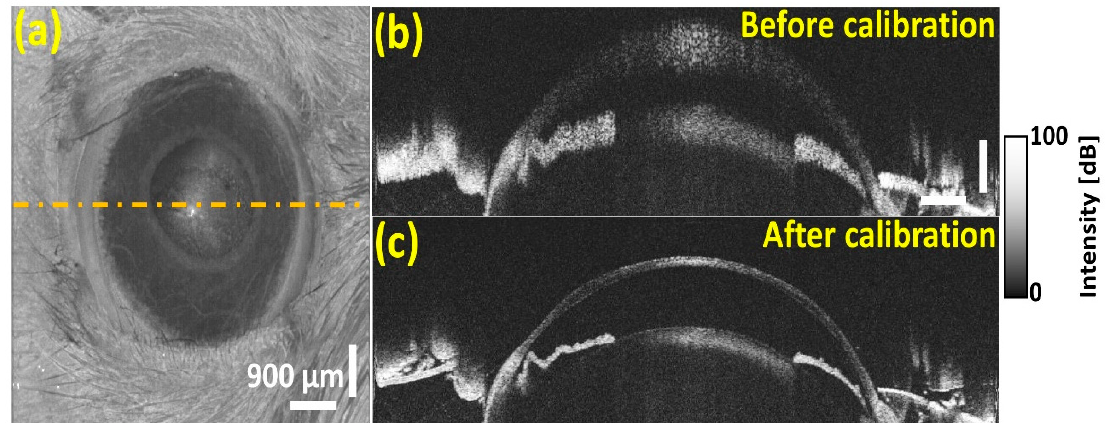
Figure 11. The OCT image verification of in vivo rat anterior vitreous opacification along with B-scans corresponds to multiple positions. ( a ) 3D enface visualization of anterior vitreous opacification, ( b ) before calibration, and ( c ) after calibration. The horizontal and vertical scale bars of ( b ) are 500 µ m and 300 µ m, respectively.